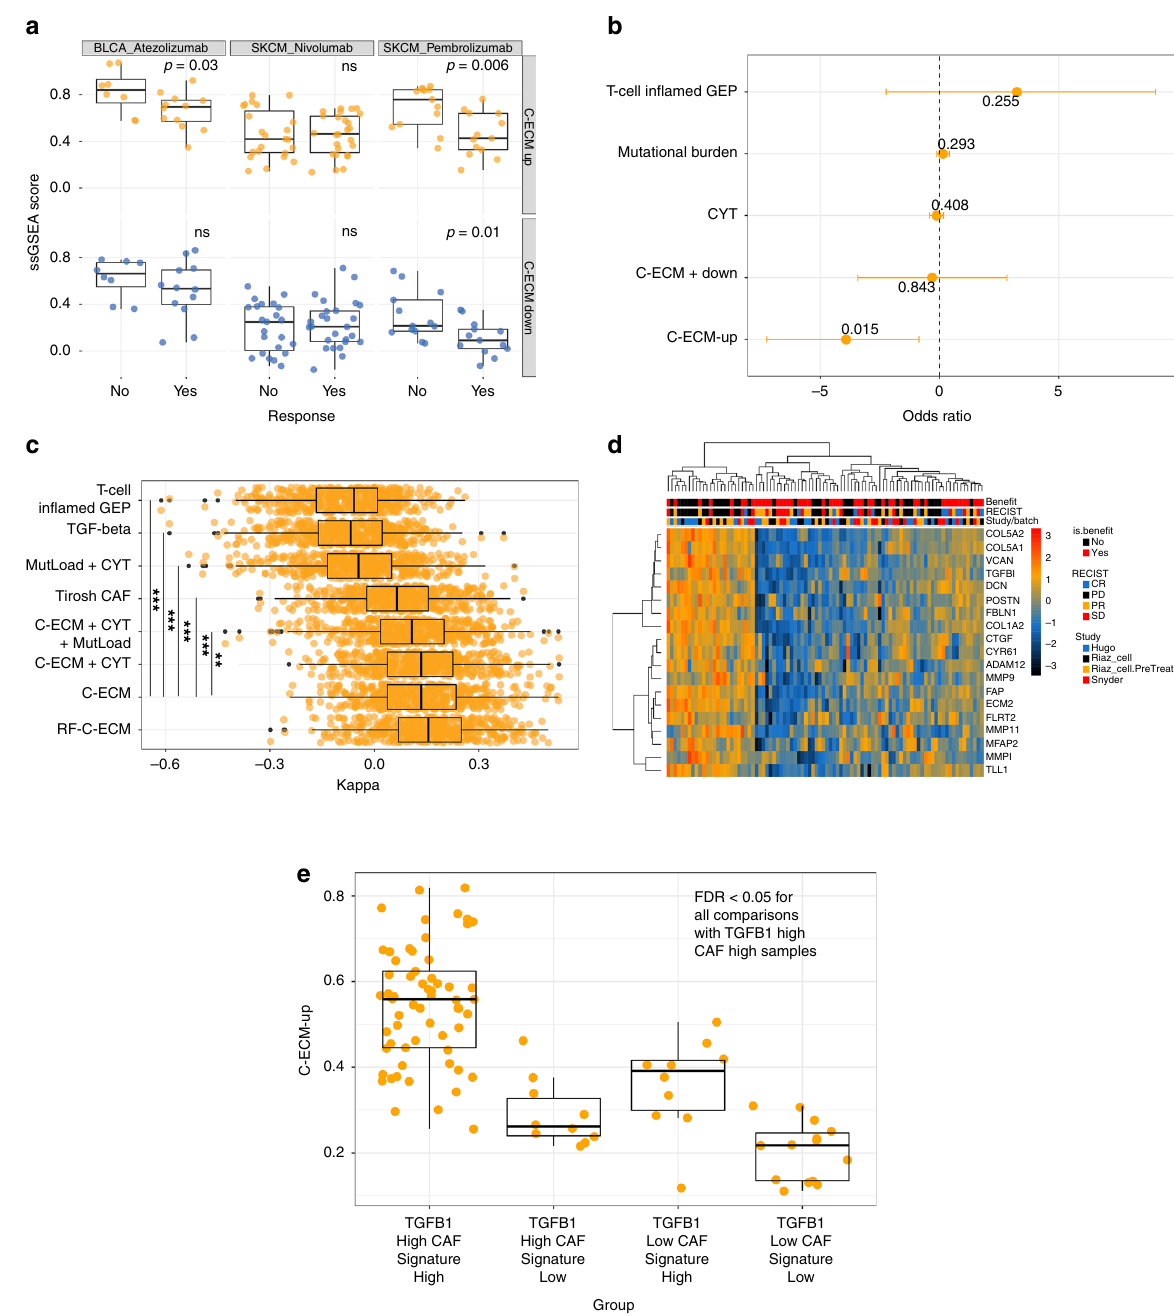
Fig. 4 C-ECM scores predict failure of PD-1 blockade. a Boxplots showing distributions of C-ECM ssGSEA scores across multiple data sets of pretreatment biopsies from patients treated with PD-1 blockade. Non-responders = progressive disease (PD). p Values are from Wilcoxon ’ s Rank Sum Test. b Coef fi cients from pooled logistic regression analysis evaluating various predictors on PD-1-blockade response, error bars indicate 95% con fi dence intervals. c Boxplots of Cohen ’ s Kappa from 0.632 bootstrapping (500 resamples), showing that ECM-based models outperform other candidate biomarkers. Asterisks show q -values. d Heatmap showing C-ECM genes differentially expressed between ICB responders and nonresponders after controlling for study-speci fi c variation. Rows show z -scores of expression (log2 CPM) and columns show samples; annotation ribbons display clinical information. e Boxplot showing C-ECM-up score distributions based on discretised categories of TGFB1 expression and the Tirosh CAF signature. All comparisons with the TGFB1 high, CAF high group were signi fi cant at FDR < 0.05 (Wilcoxon ’ s Rank Sum